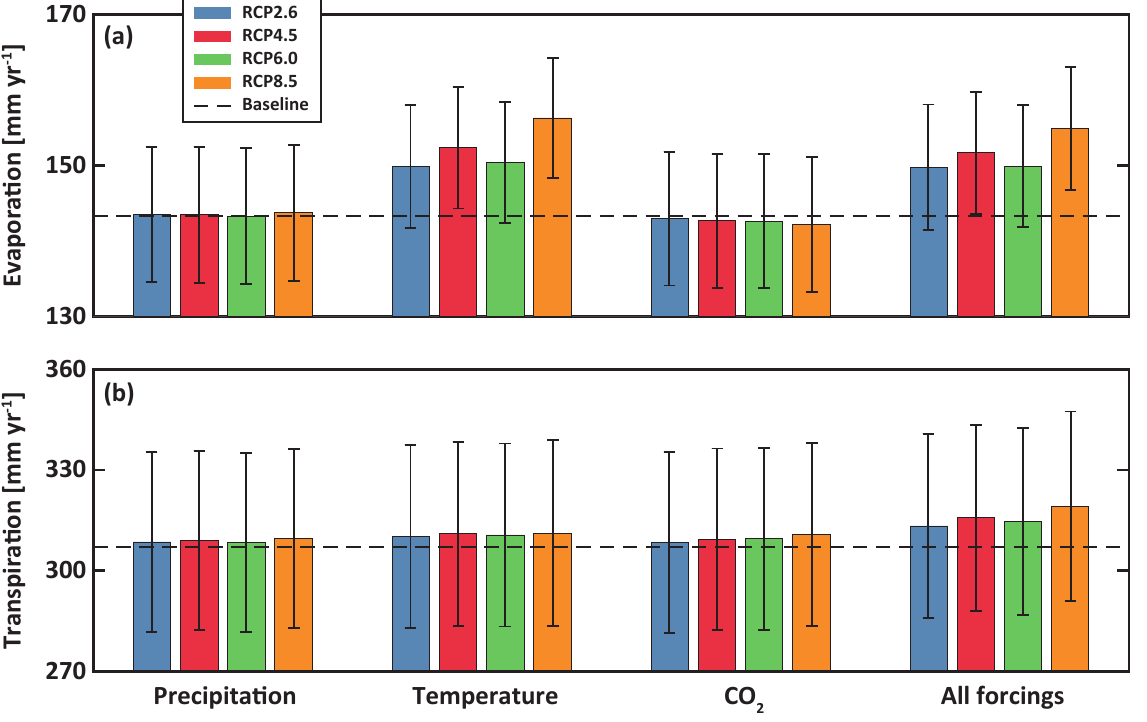
Figure 6. Projected ( a ) evaporation and ( b ) transpiration over the 50-year study period for the scenario of precipitation change alone (first column), temperature change alone (second column), CO 2 change alone (third column), and all together (fourth column) under RCP 2.6 (blue), 4.5 (red), 6.0 (green), and 8.5 (orange) for the 2050s (from 2036 to 2065). Error bars are standard deviations. The variables at baseline, climate conditions based on the 2010s (from 1986 to 2015), are shown in dashed